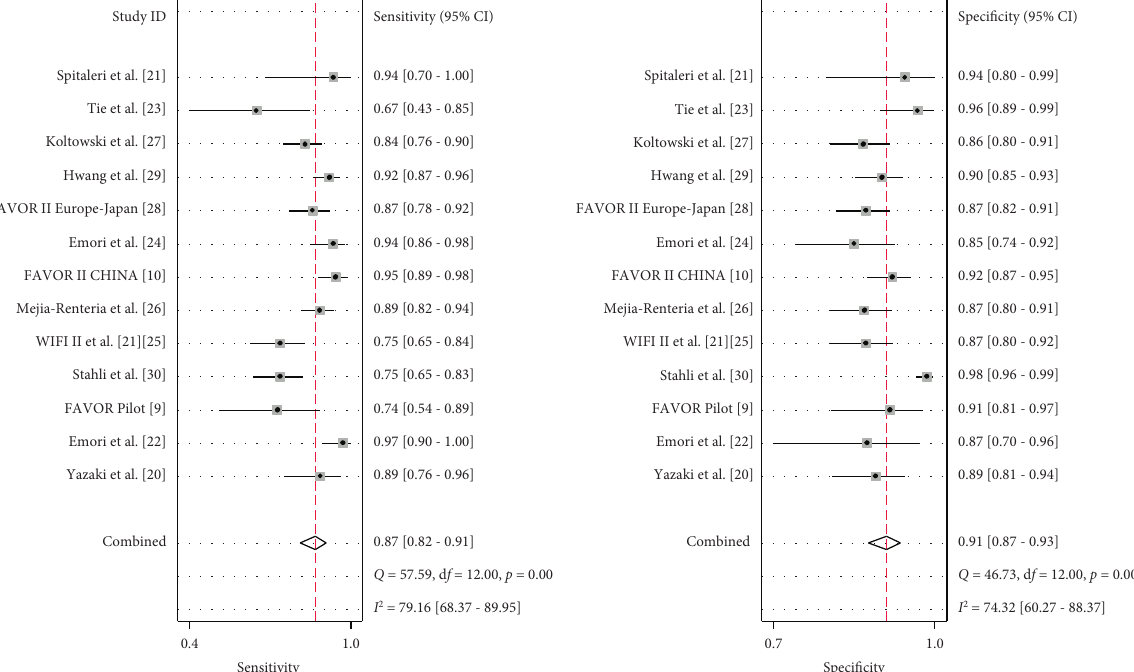
Figure 3: Forest plots for sensitivity and specificity of QFR. CI: confidence